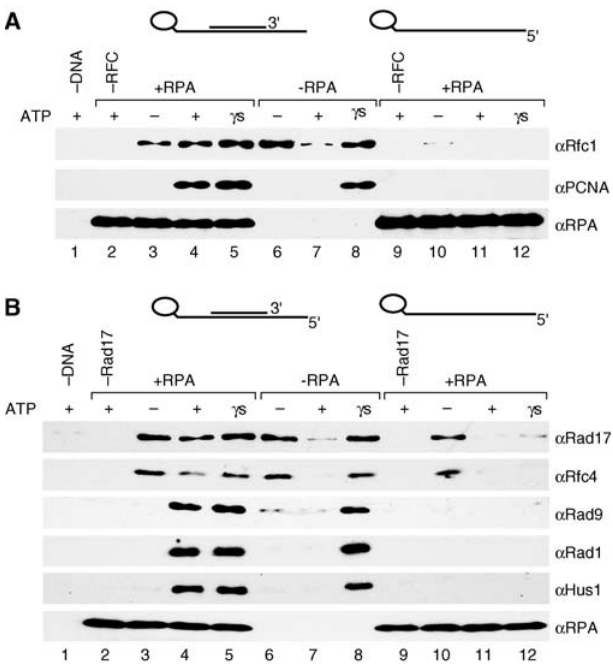
Figure 3. RHR Loading Is Nucleotide, Primer, and RPA Dependent Loading reactions represented in (A) were performed with 2 pmol of PCNA, 0.25 pmol of RFC, and the 5 9 and 3 9 recessed primer–template DNA–RPA complex bound to beads, whereas those in (B) were performed with 1 pmol of RHR, 0.25 pmol of RSR, and the 5 9 and 3 9 recessed primer–template DNA–RPA complex bound to beads. Reactions were performed as described in the Materials and Methods, and the bead-precipitated proteins were then analyzed by Wb for PCNA, RFC, Rad17, Rad9, Hus1, and Rad1, respectively. In both (A)